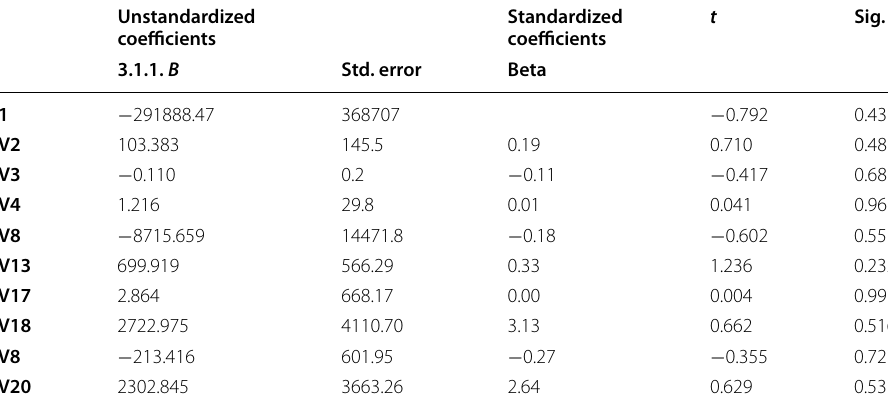
Table 8 Regression results for factor 1